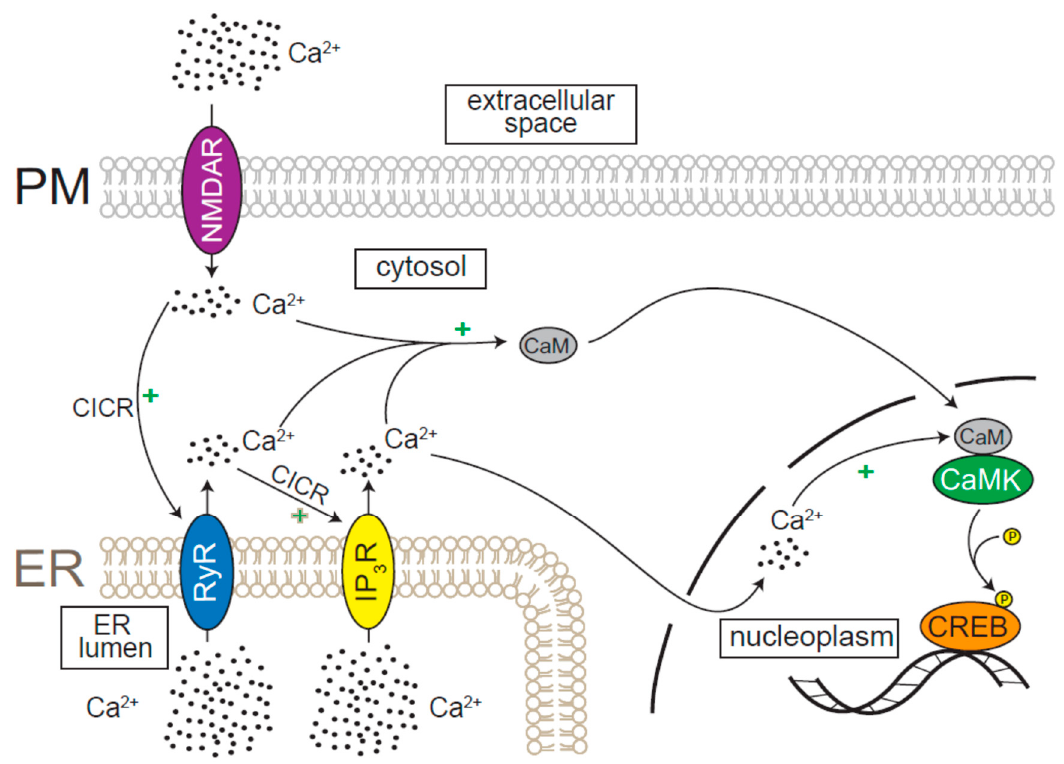
Figure 3. Ca 2 + -mediated activation of neuronal gene expression. Dendritic stimulation activates channels on the plasma membrane (PM), such as the N-methyl-D-aspartate receptor (NMDAR), which allow Ca 2 + influx. RyR responds to Ca 2 + entry and the signal is amplified through Ca 2 + -induced Ca 2 + release (CICR). Subsequent activation of IP 3 R causes further Ca 2 + release and activation of calmodulin (CaM). CaM may be activated either directly in the nucleus or in the cytosol, in which case it translocates to the nucleus, and activates Ca 2 + / calmodulin-dependent protein kinases (CaMKs). CaMKs phosphorylate cAMP response element binding (CREB) protein, which binds to DNA and drives changes in gene expression.